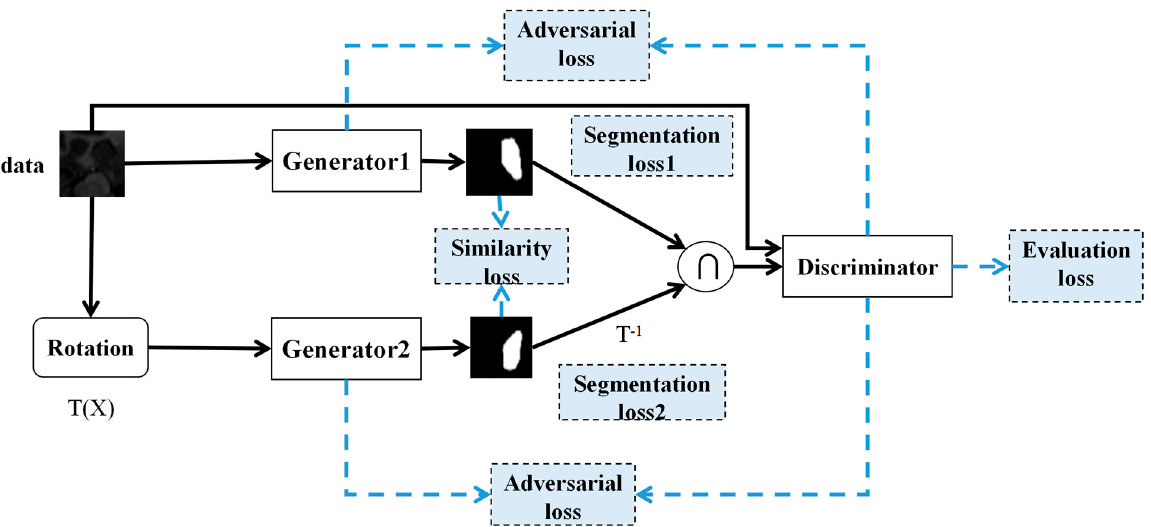
Figure 2. Configurations of Diff-CoGAN framework showing two generators and one discriminator. The input data comprise 2D labeled and unlabeled image datasets. The input to Generator 1 is the original dataset, while Generator 2 is fed the transformed (TX) dataset. T(X) is a 180° rotation of the original dataset. Consequently, predicted maps are generated by the two generators and are intersected (notated by the intersection, ∩ ) to be the input to the discriminator. Prior to intersection, the predicted map output from Generator 2 is inversed, which is notated by T -1